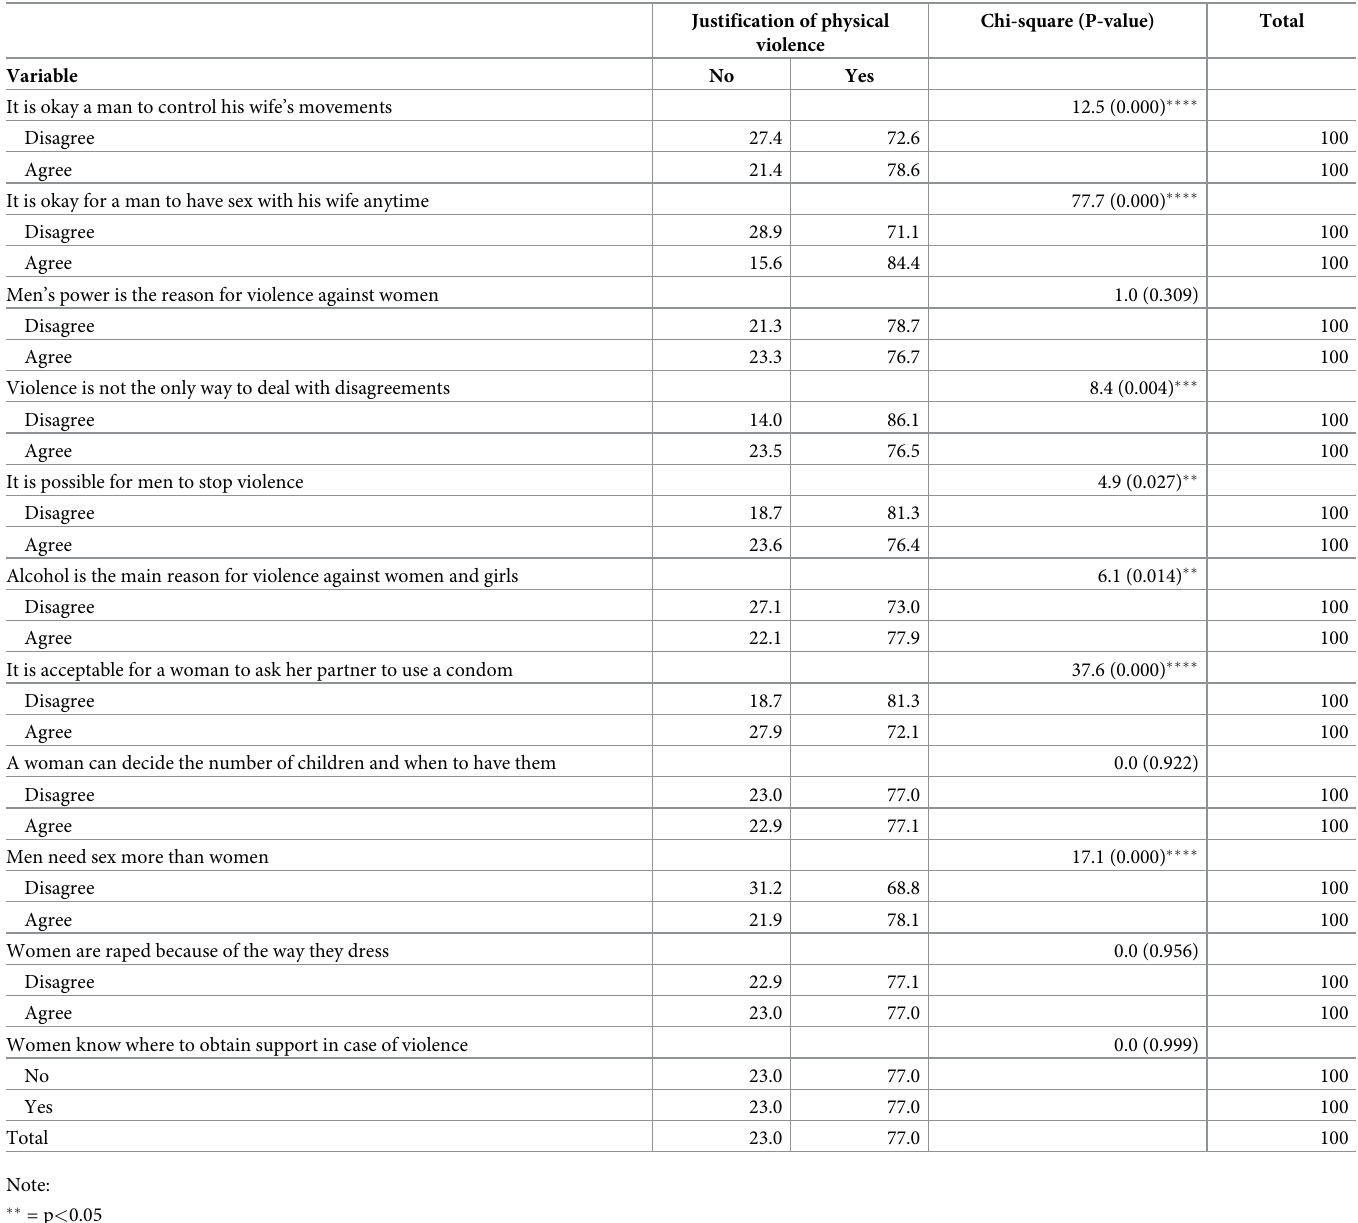
Table 4. Relationship between attitudes towards violence and justification of physical violence against